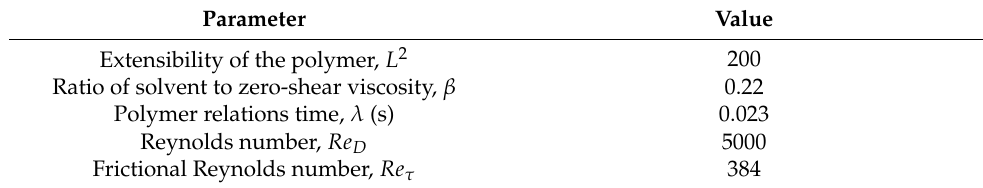
Table 2. Parameter space for the current study. Parameter Value Extensibility of the polymer, L 2 200 Ratio of solvent to zero-shear viscosity, β 0.22 Polymer relations time, λ (s) 0.023 Reynolds number, Re D 5000 Frictional Reynolds number, Re τ